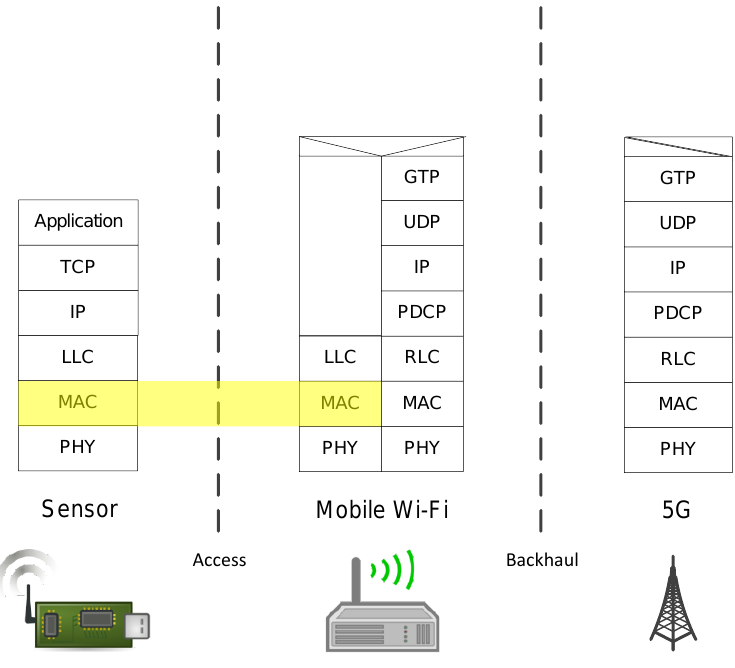
Figure 2. Mobile Wi-Fi protocol stack .